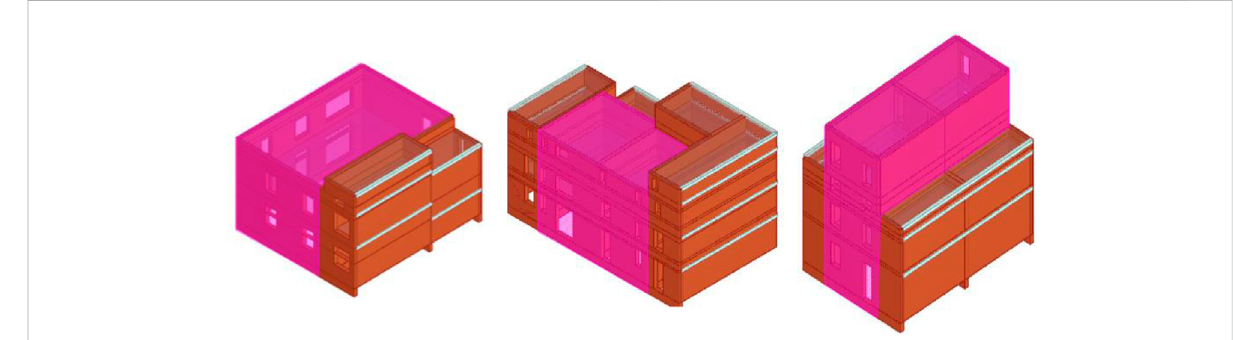
FIGURE 10 Three SU of the masonry building compound in Mirandola under numerical investigation.